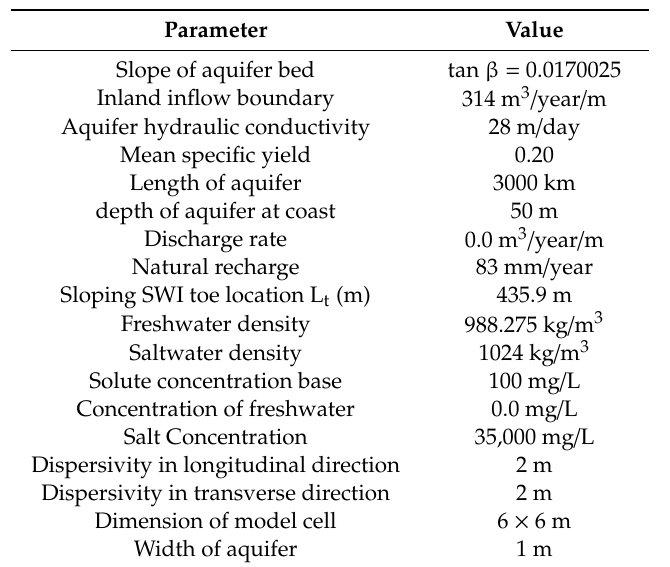
Table 5. Parameters of Cyprus aquifer [52] and SEAWAT numerical model